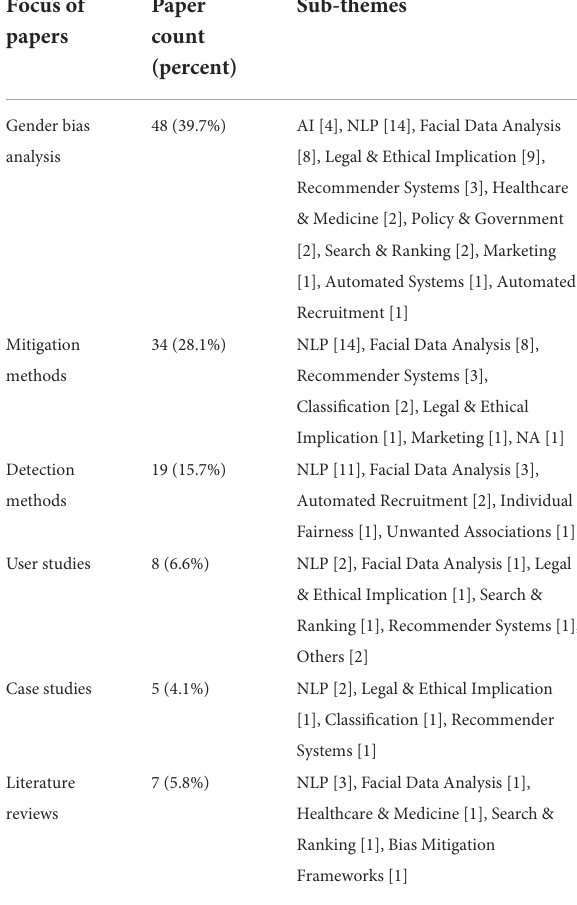
TABLE 1 Distribution of papers collected for this review based on the focus of